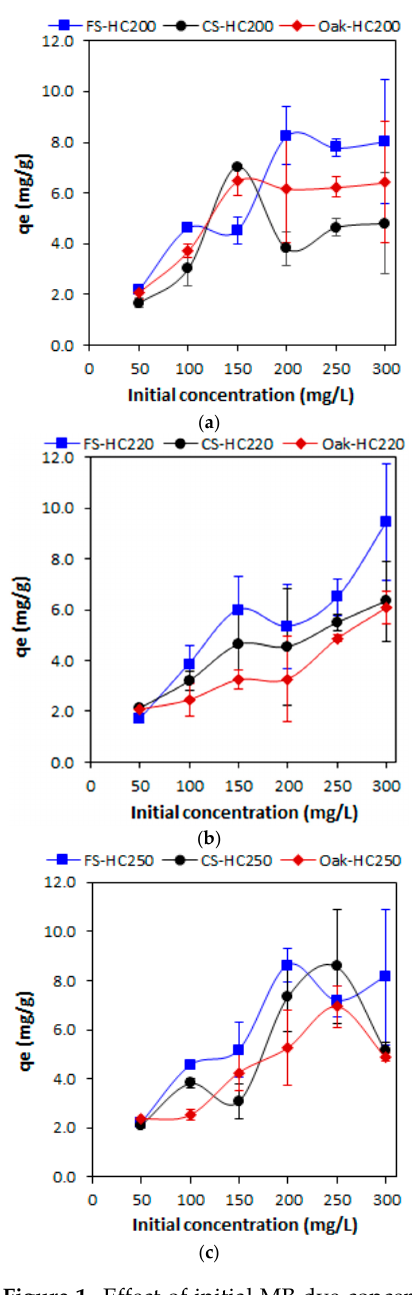
Figure 1. Effect of initial MB dye concentration and HTC temperature on adsorption capacity of hydrochars derived at: ( a ) 200 °C; ( b ) 220 °C; and ( c ) 250 °C.